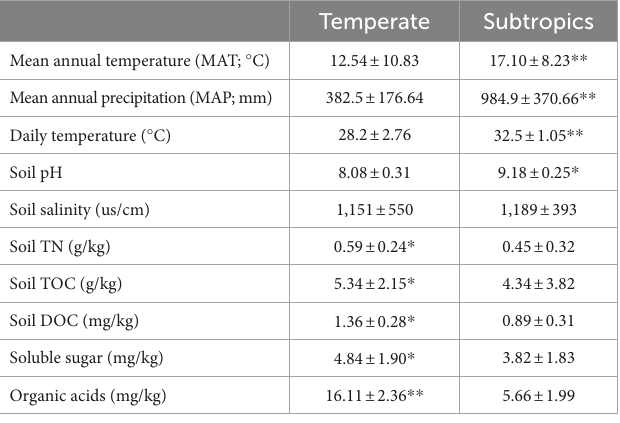
TABLE 1 Chemical properties of the soils in different